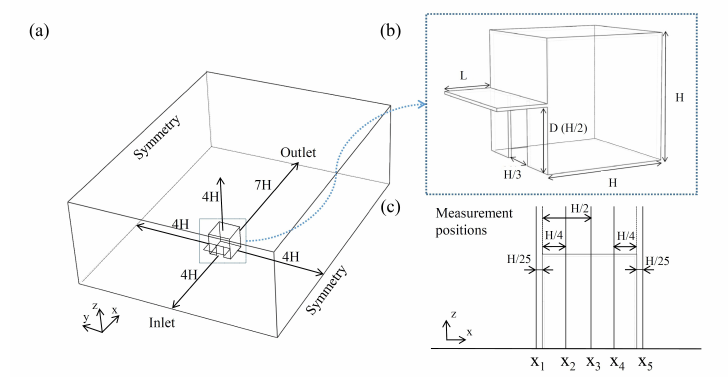
Figure 1. Schematics of ( a ) the computational domain; ( b ) an idealized building model with an overhang; and ( c ) the measurement positions.